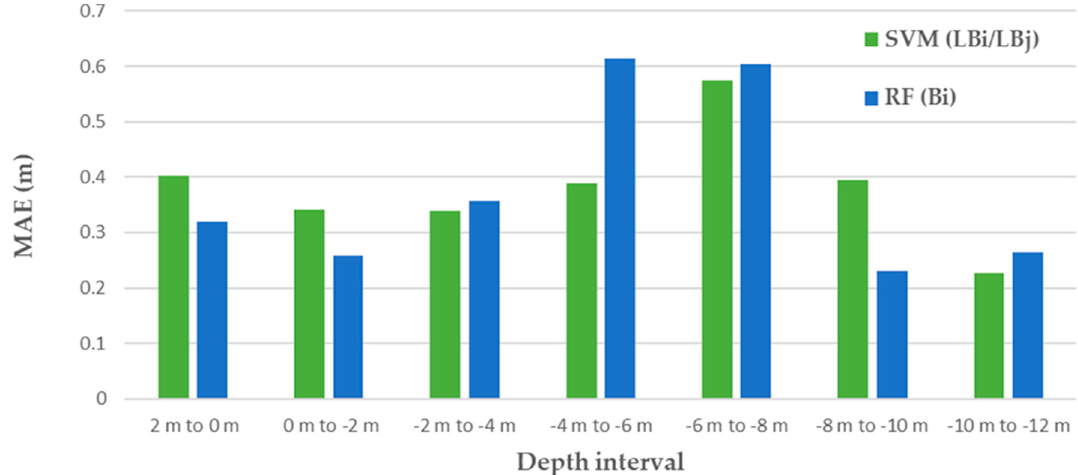
Figure 12. Variation of MAE errors versus depth interval in the port area for the two selected algorithms: RF-bands and SVM-Ratios.